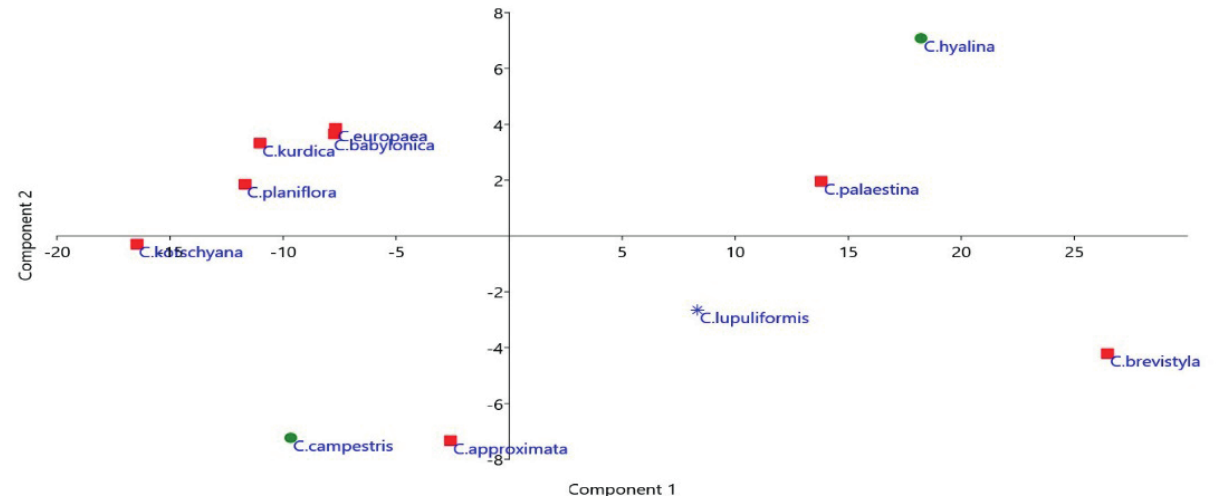
Figure 4. PCA analysis scatter plot (same colors are the same